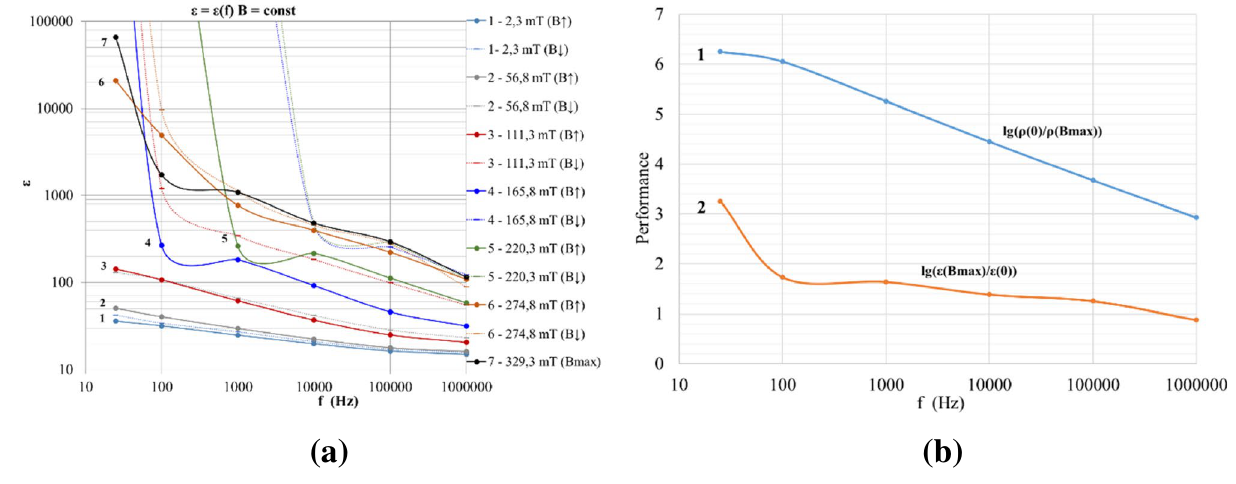
an MAE sample with isotropic structure, containing 72 wt% of iron Fig. 12 Performance, B being 330 mT ( a ) and dielectric perme- max particles obtained by the grinding of a carbonyl iron powder with ability at various magnetic induction magnitudes while the field spherical particles in n -heptane followed by nickel-electroplating increases (‘ ↑ ’, solid lines) and decreases (‘ ↓ ’, punctured lines) ( b ) as (concentration of nickel in the pure powder—2.46 functions of the frequency of the passing current demonstrated by